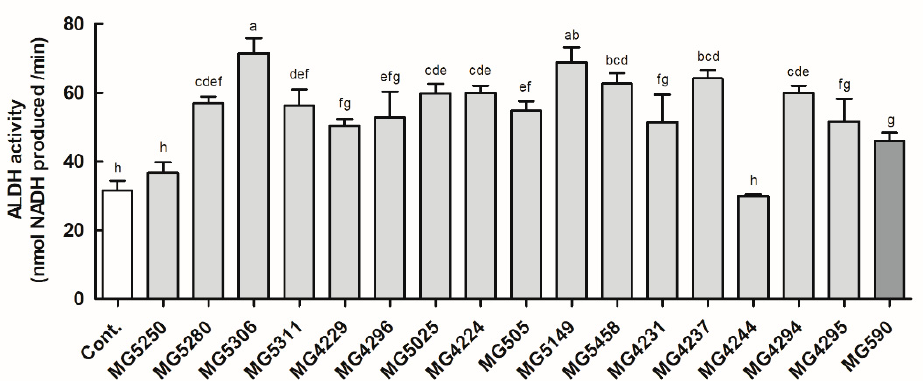
Figure 1. Effect of CFEs (5 mg/mL) from LAB strains on ALDH activity. Data are expressed as the mean ± SD ( n = 3). Different letters above the columns indicate significance at p < 0.05 based on Duncan’s test. Cont, control.